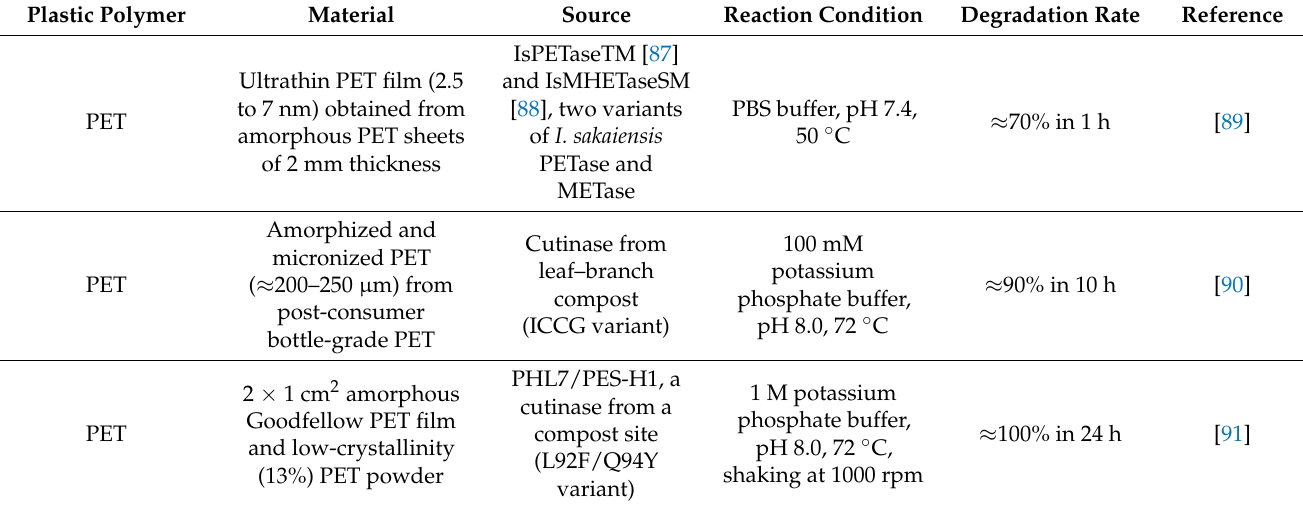
Table 4. List of the most performant biological systems for traditional petroleum-based plastic degradation known to date. They are ordered by plastic polymer type and listed by decreasing degradation